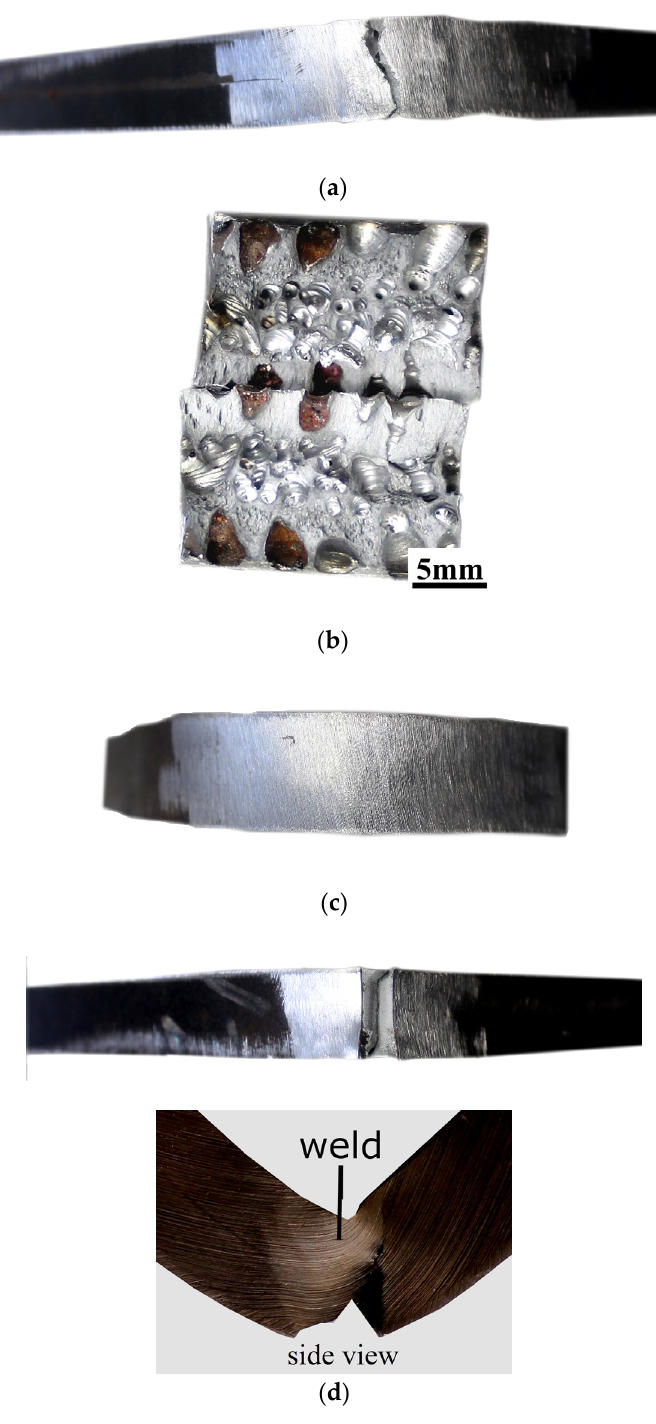
Figure 12. Specimens after bending test: ( a ) Sample 3 performed in the water, bent with tensile from the root of the weld; ( b ) Sample 4 performed in the water, bent with tensile from the face of the weld; ( c ) Sample 2 performed in the air, bent with tensile from the root of the weld; ( d ) Sample 3 performed in the air, bent with tensile from the root of the weld.